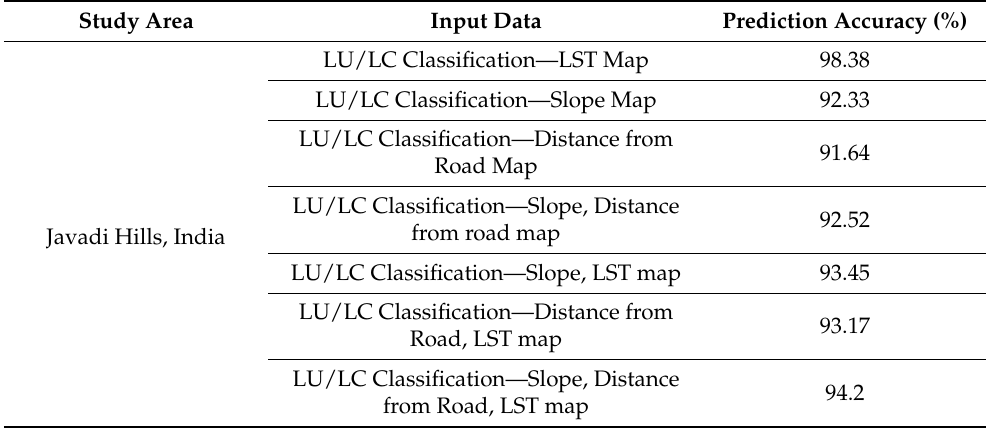
Table 13. Testing of the Vision Transformer–based Bi-LSTM model using the various combinations of Input Spatial Data for Javadi Hills, India.